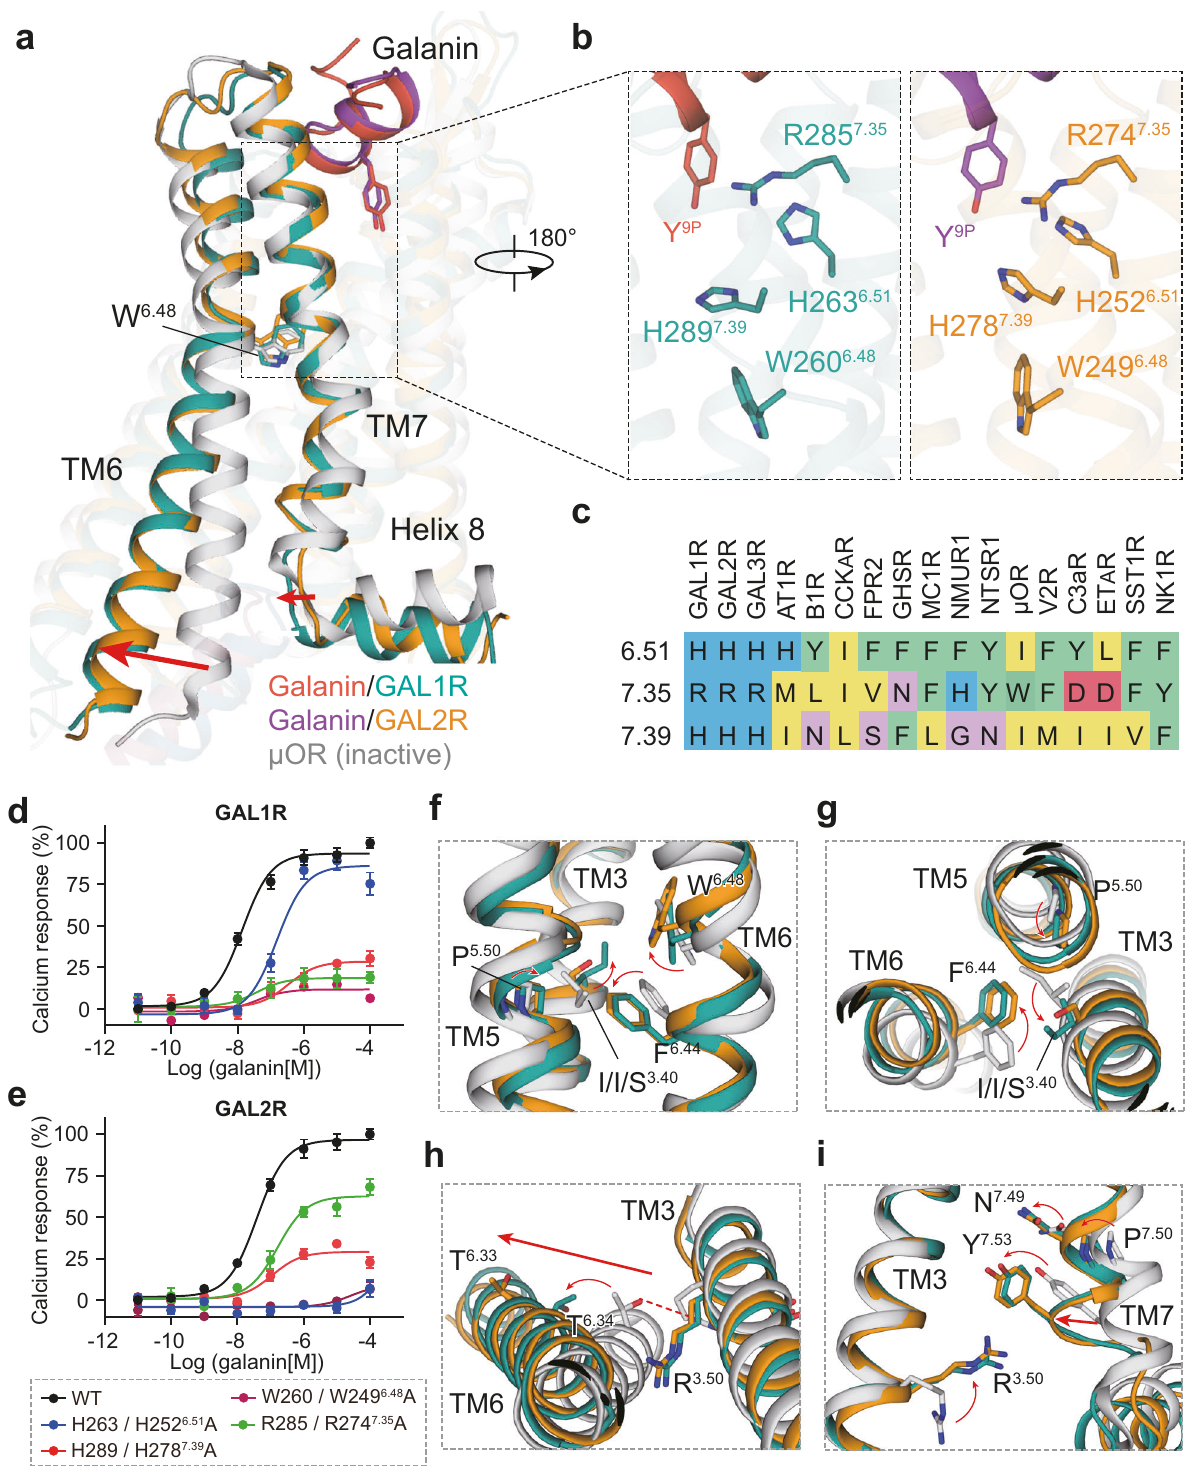
Fig. 4 The unconventional activation mechanism of GAL1R and GAL2R. a Structural comparison of GAL1R-G i and GAL2R-G q complexes with μ OR in the inactive state (PDB: 6DKL). The outward movement of TM6 and inward shift of TM7 in galanin receptors relative to μ OR are shown as red arrows, indicative of the fully active conformation of both galanin receptors. b Three positively charged residues involved in agonism signaling transmission of galanin in GAL1R (left panel) and GAL2R (right panel). c Sequence alignment of residues at 6.51, 7.35, and 7.39 in class A peptide GPCRs. The effects of mutation of three positively charged residues on galanin-induced activation of GAL1R ( d ) and GAL2R ( e ). WT and receptor mutants were transfected into HEK293/G α 16 cells and intracellular calcium response was measured to re fl ect the activity of galanin. Data shown are mean ± S.E.M. of six independent experiments ( n = 6). Source data are provided as a Source Data fi le. f – i The conformational rearrangement of residues in conserved “ micro-switches ” upon galanin receptors activation. In contrast to μ OR in the inactive state, the conformational changes of “ micro-switches ” residues in toggle switch ( f ), PIF ( g ), DRY ( h ), and NPxxY ( i ) of GAL1R and GAL2R are indicated as red arrows. The movement of TM6 and TM7 are highlighted as red